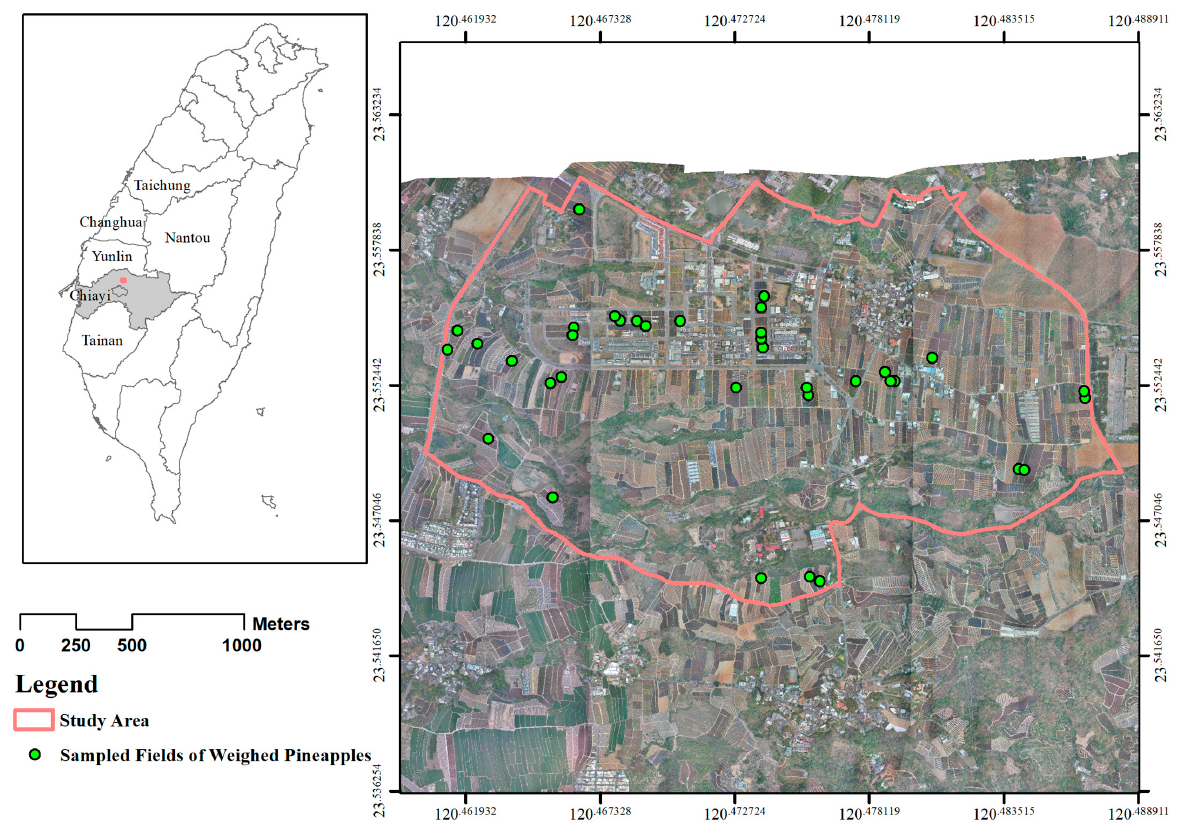
Figure 1. Study area, sampled fields and the UAV image with GSD 3 cm.